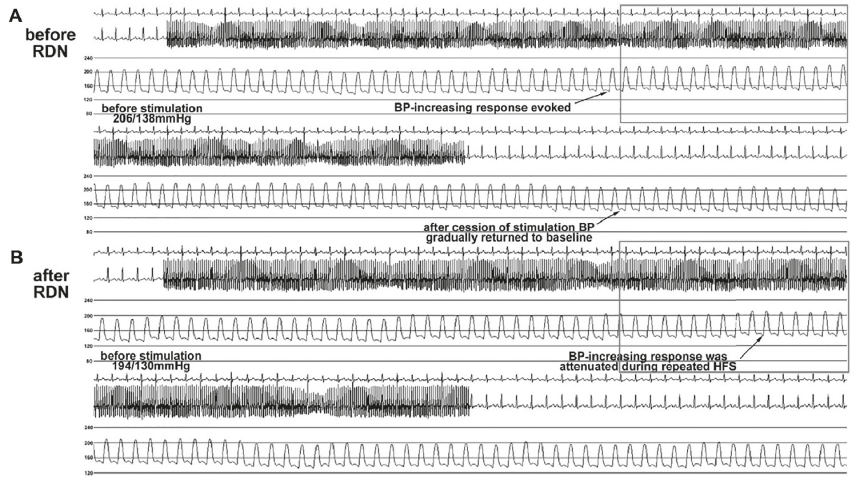
Figure 3: (a) An example of renal nerve stimulation evoking elevation of blood pressure before renal denervation; (b) the same stimulated site of (a) that elevation of blood pressure has been attenuated after renal denervation, implying a success in destruction of renal nerves. Reproduced from reference